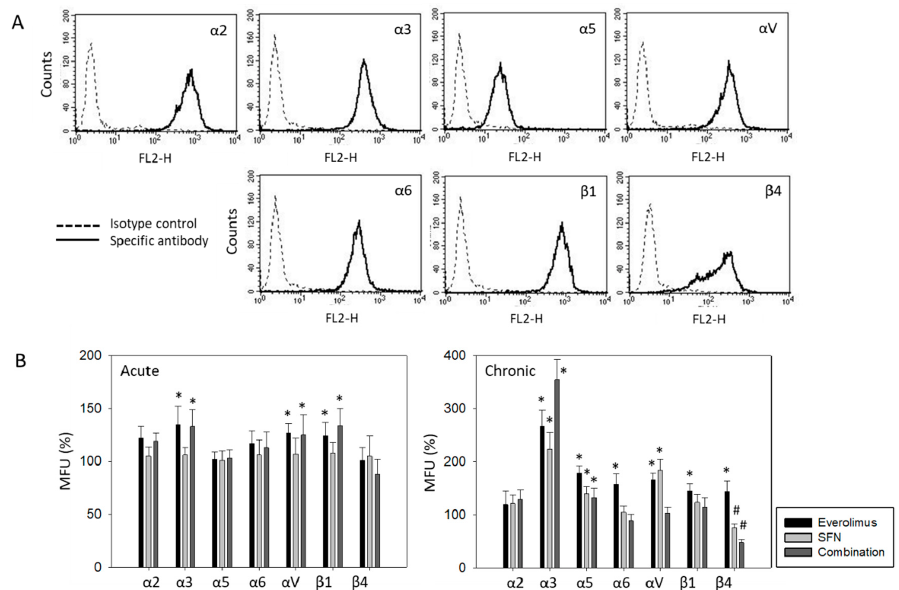
Figure 5 . ( A ) Surface expression of integrin α and β subtypes on RT112 cells. Counts indicate mean fluorescence units (MFU). One representative of three separate experiments is shown. Solid line: specific fluorescence; dashed line: isotype control. ( B ) Expression level of integrin α and β subtypes